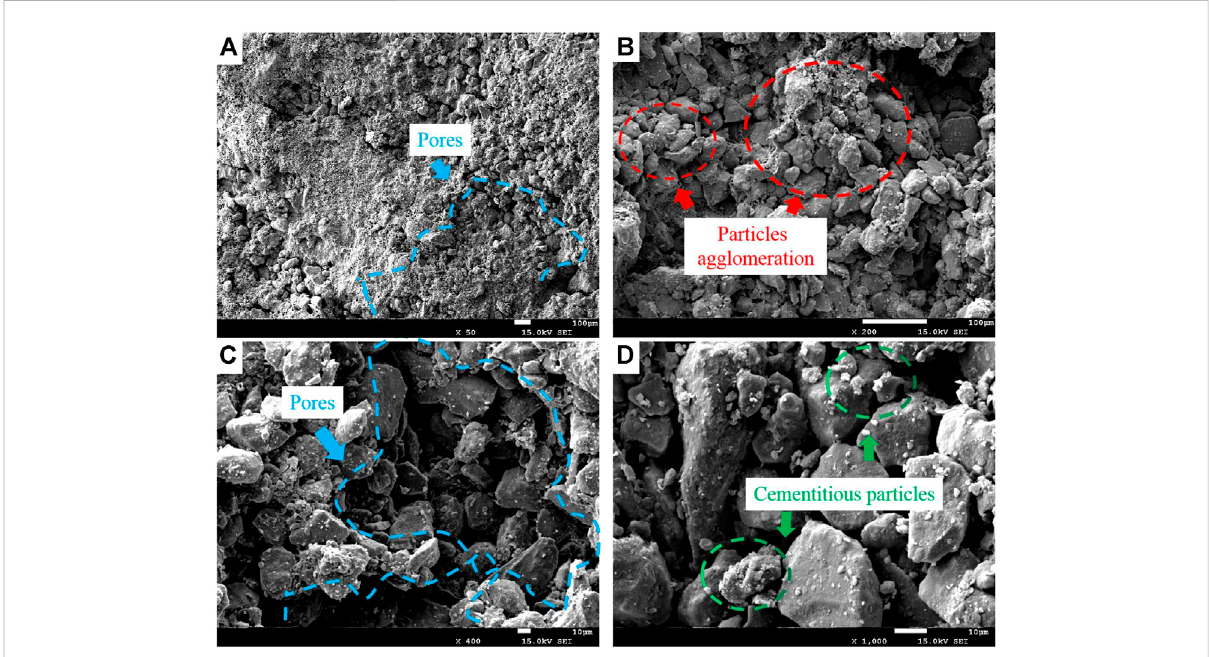
FIGURE 7 Electron microscopic scanning of the sample at disease segment: (A) Sample No.2 – 50 times, (B) sample No.2 – 200 times, (C) sample No.2 – 400 times, (D) sample No.2 – 1,000 times.